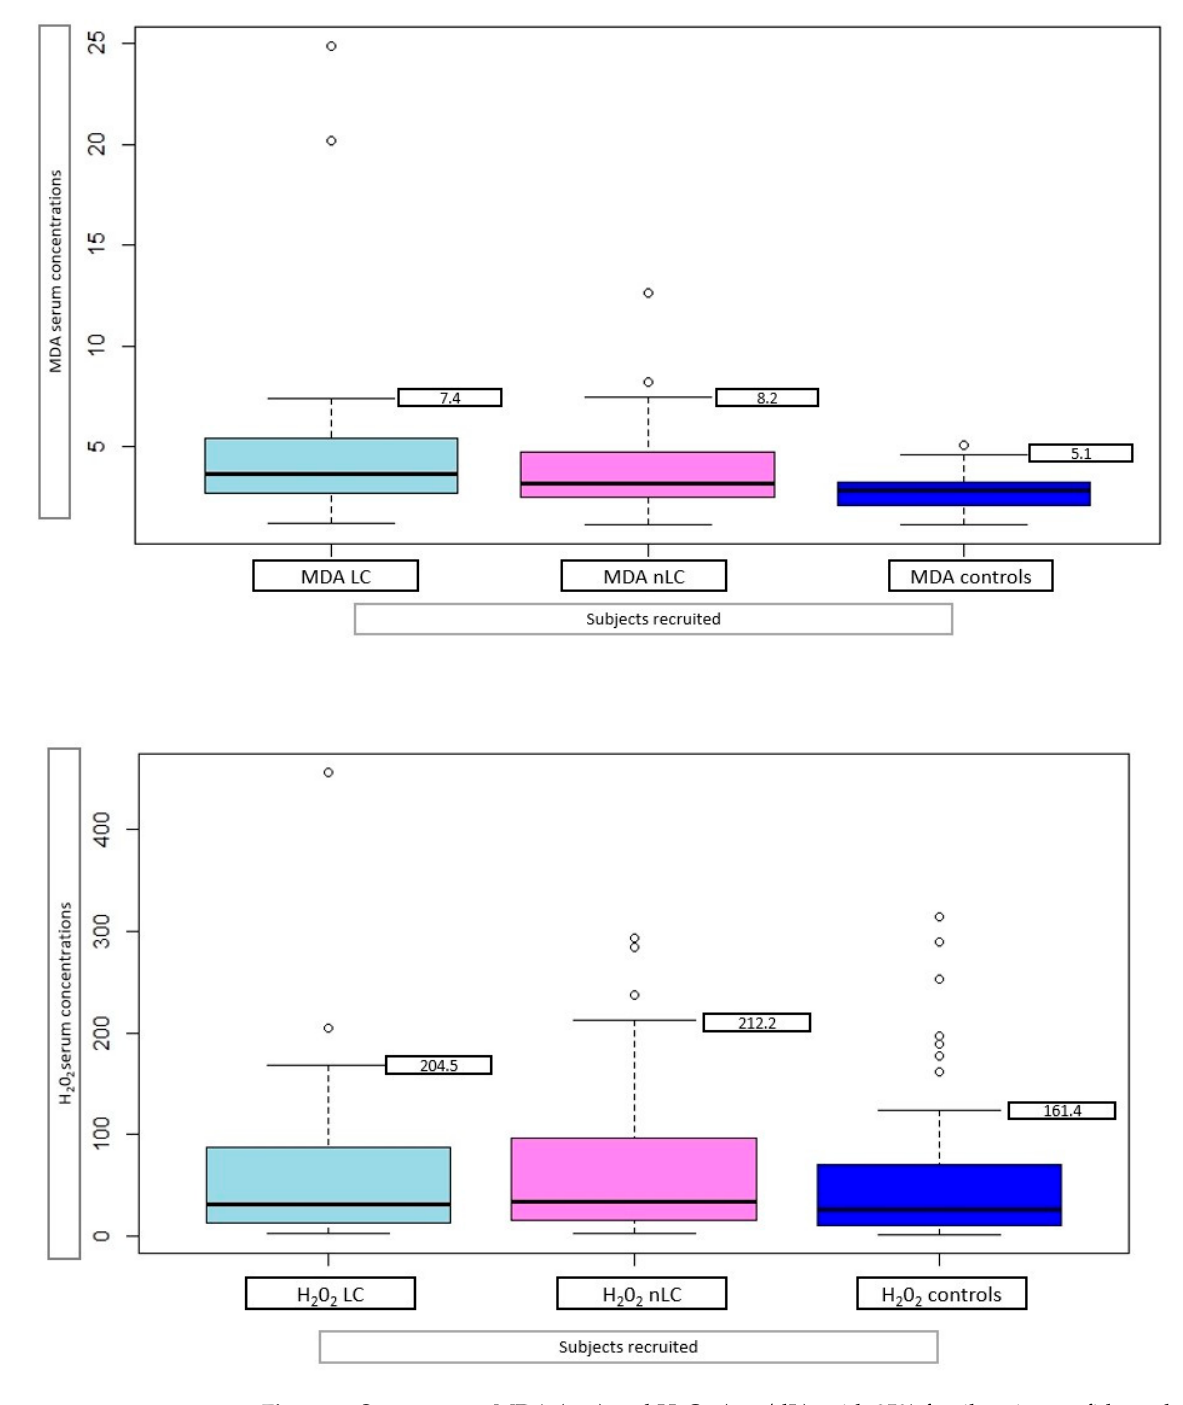
Figure 2. Serum mean MDA ( µ m) and H 2 O 2 (mg/dL), with 95% family-wise confidence level, in 34 long-COVID (LC) patients, 46 non-long-COVID (nLC), and 47 controls. Demographic characteristics and clinical variables of COVID-19 patients subdivided according to the presence of symptoms (LC vs. nLC patients, respectively) are shown in Table 2. A higher prevalence of the female sex and patients requiring oxygen therapy during the acute infection was found in the LC than in nLC patients (19% vs. 6%, and 4% vs. 0%, respectively, p < 0.001). In addition, this group had significantly higher IgG values and lower mean hematocrit values than the nLC patients (Table